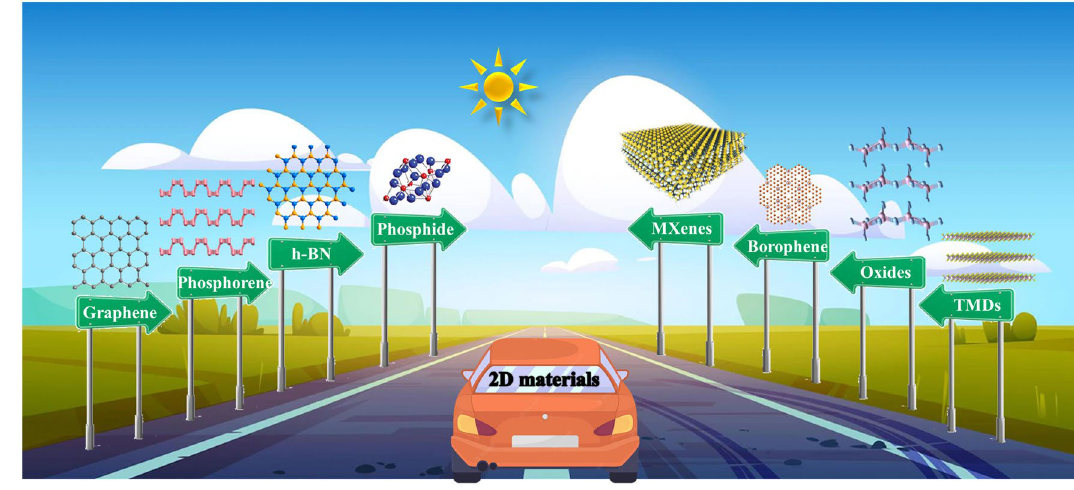
Fig. 1 The rapid development of two-dimensional materials. Reproduced with permission from Ref.